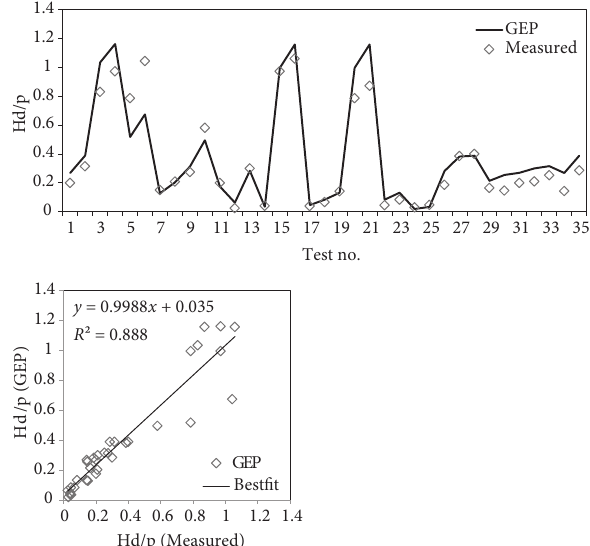
/P versus measured ones for test d